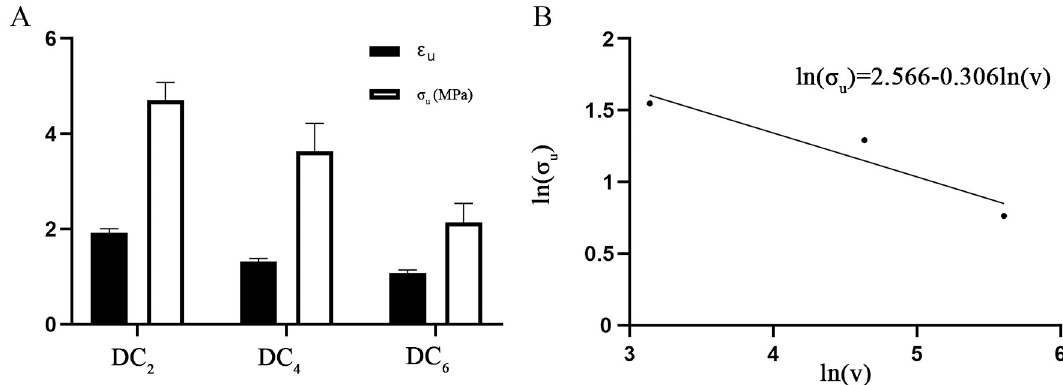
Fig 7. The ultimate values in the DC groups. (A) Comparison of ε u and σ u among the DC groups. (B) Logarithmic plot of the strength size effect of the DC groups.